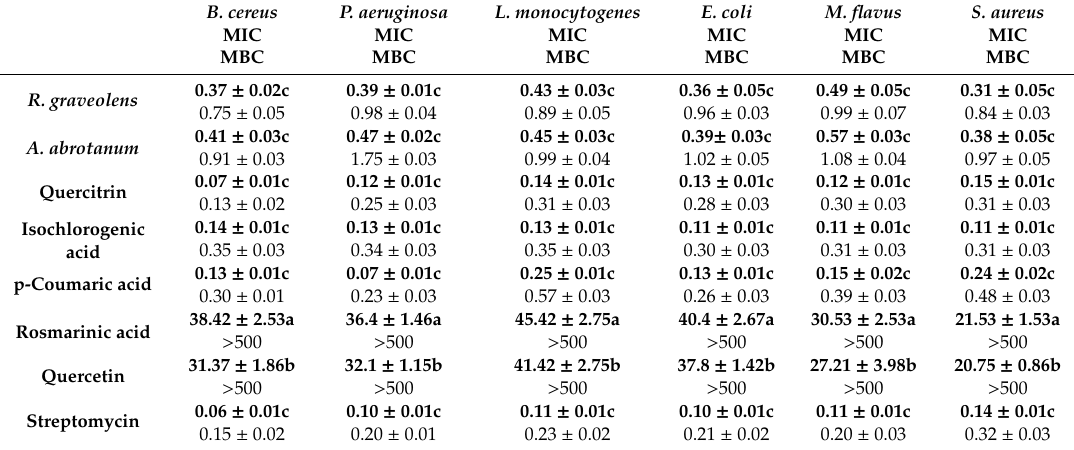
Table 4. Minimum inhibitory concentration (MIC) and minimum bactericidal concentration (MBC) of the methanolic leaf extracts of Ruta graveolens and Artemisia abrotanum and the identified polyphenols (pure standards) against a range of bacterial species (mg / mL). Values are means of three replicates.